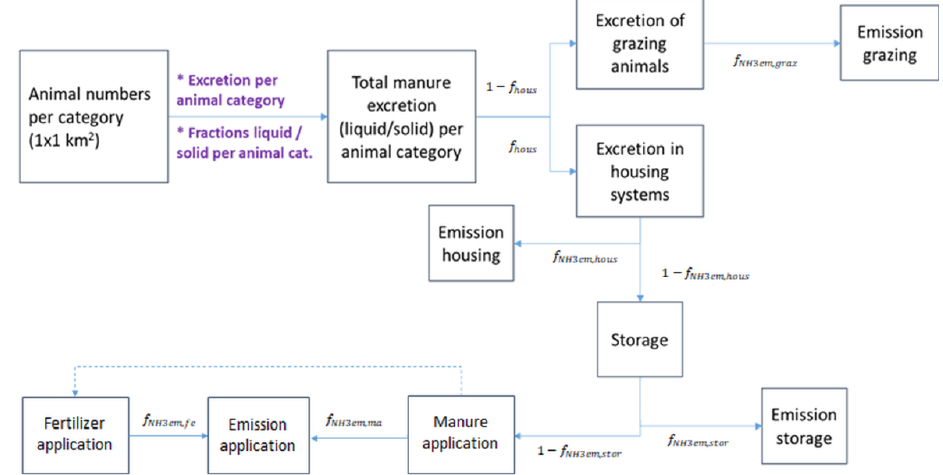
Figure 2. A schematic workflow of the NH 3 emission module in INTEGRATOR. f hous is the fraction of total manure excretion going to housing systems. f NH3em,graz , f NH3em,hous , f NH3em,stor , f NH3em,ma and f NH3em,fe represent emission fractions of grazing, animal housing, manure storage, manure application, and fertilizer application,